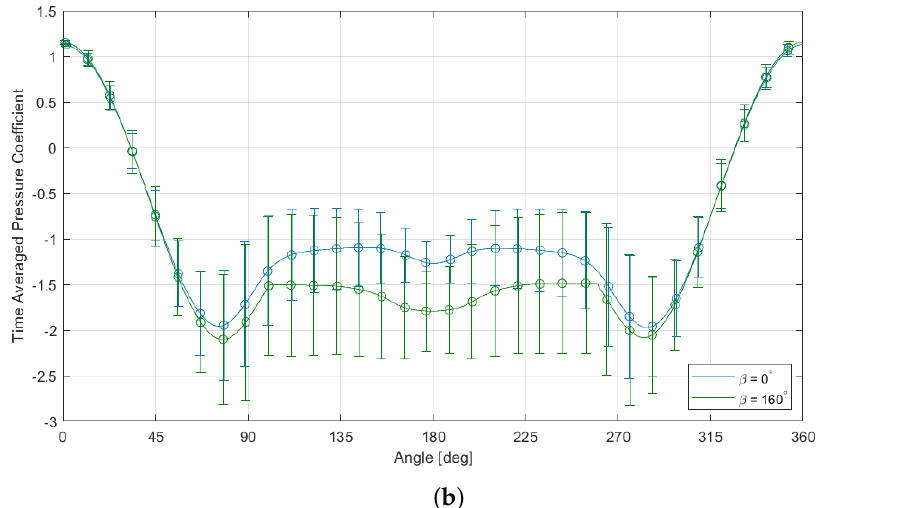
Figure 5. Time-averaged C p for the smooth cylinder and varying coating angle β with standard deviation bars at Re = 4.2 × 10 4 , constant thickness t / D = 14.3% and a porosity of 20 PPI. ( a ) β = 100 ◦ . ( b ) β = 160 ◦ .